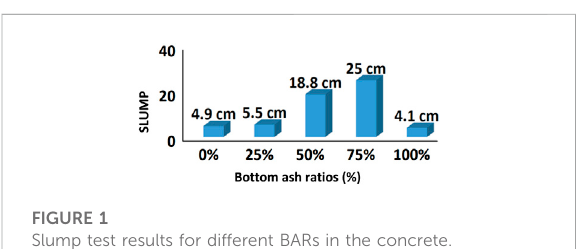
FIGURE 1 Slump test results for different BARs in the concrete.